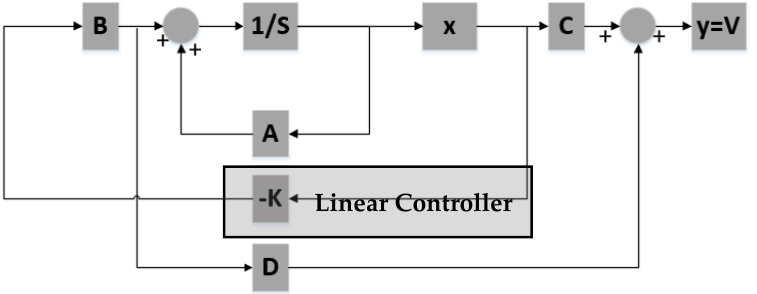
Figure 8. Full-state feedback using poles placement block diagram.